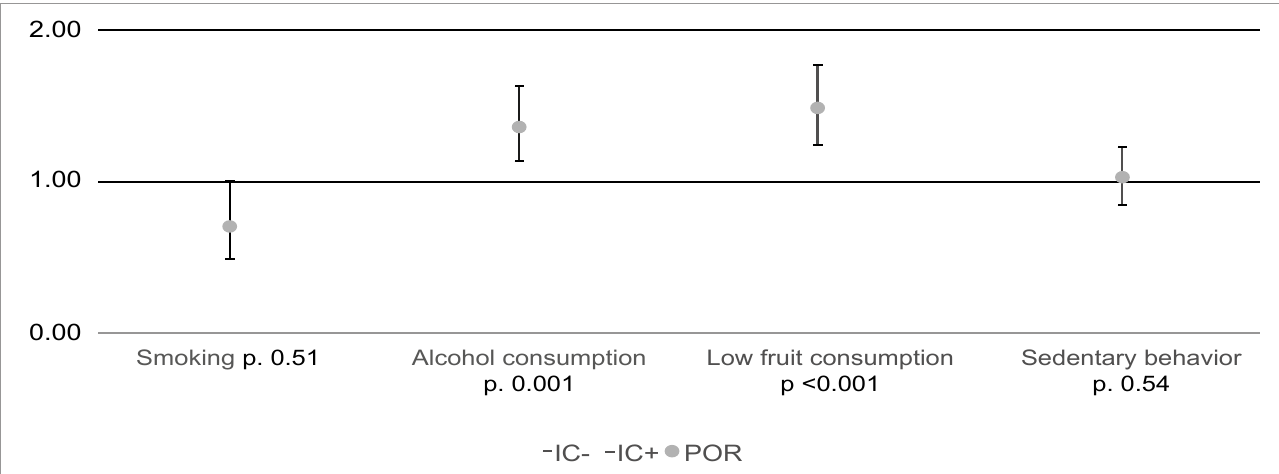
CI=Confidence interval. HRB=Health risk behaviors. Data were analyzed using Chi-square tests.